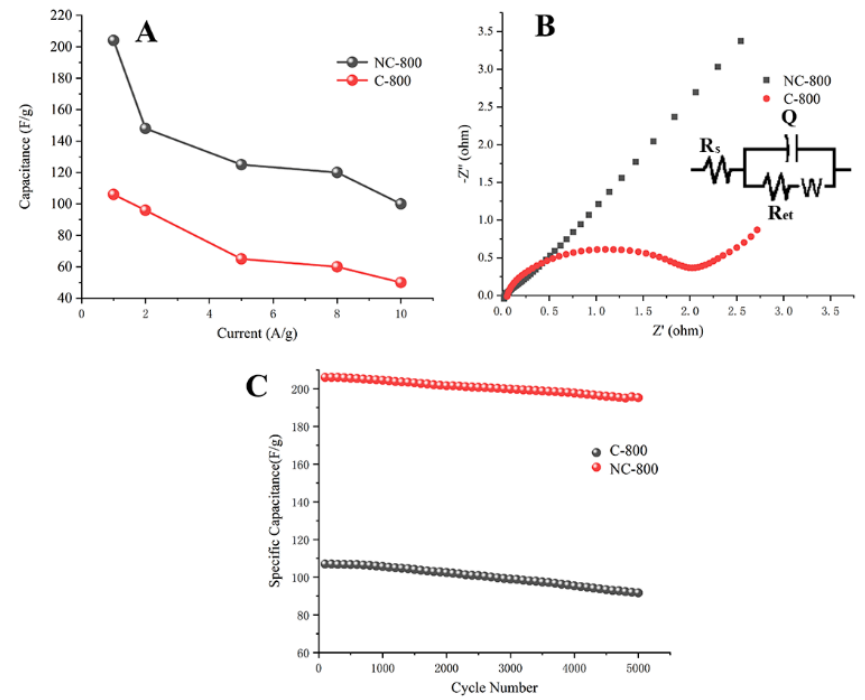
Figure 4. ( A ) Specific capacities of NC − 800 and C − 800 at different specific currents; ( B ) Nyquist plots of NC − 800 and C − 800; ( C ) cycle stability of NC − 800 and C − 800.